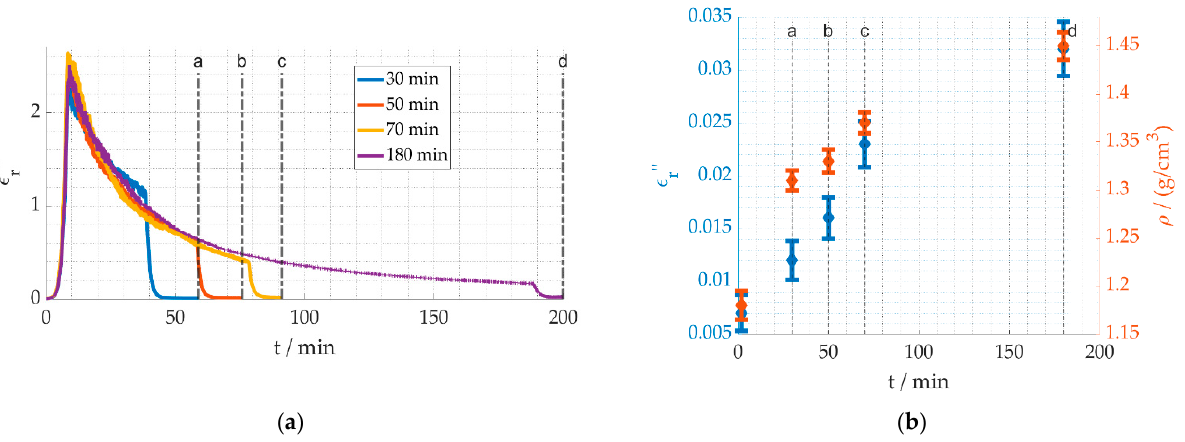
Figure 6. Dielectric loss and densities for different process times with a process temperature of 260 °C (Adapted from [31]). ( a ) Time dependent change of the dielectric loss for different process times. ( b ) Dielectric loss and density at room temperature after the process.